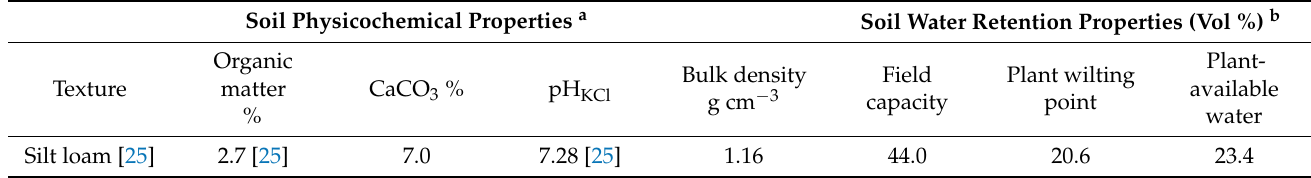
Table 2. Selected properties of the analyzed topsoil (Ap